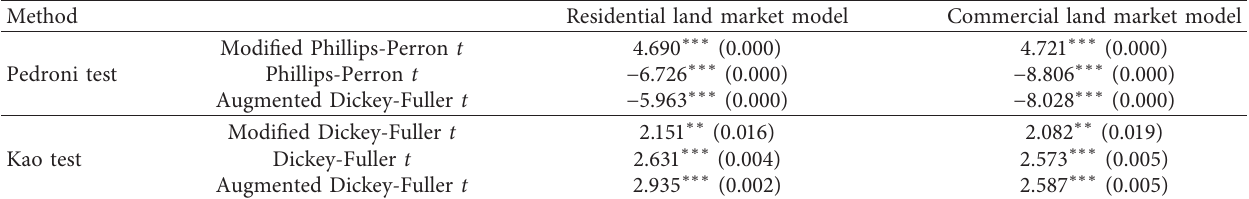
Table 5: The results of the cointegration test for panel data.